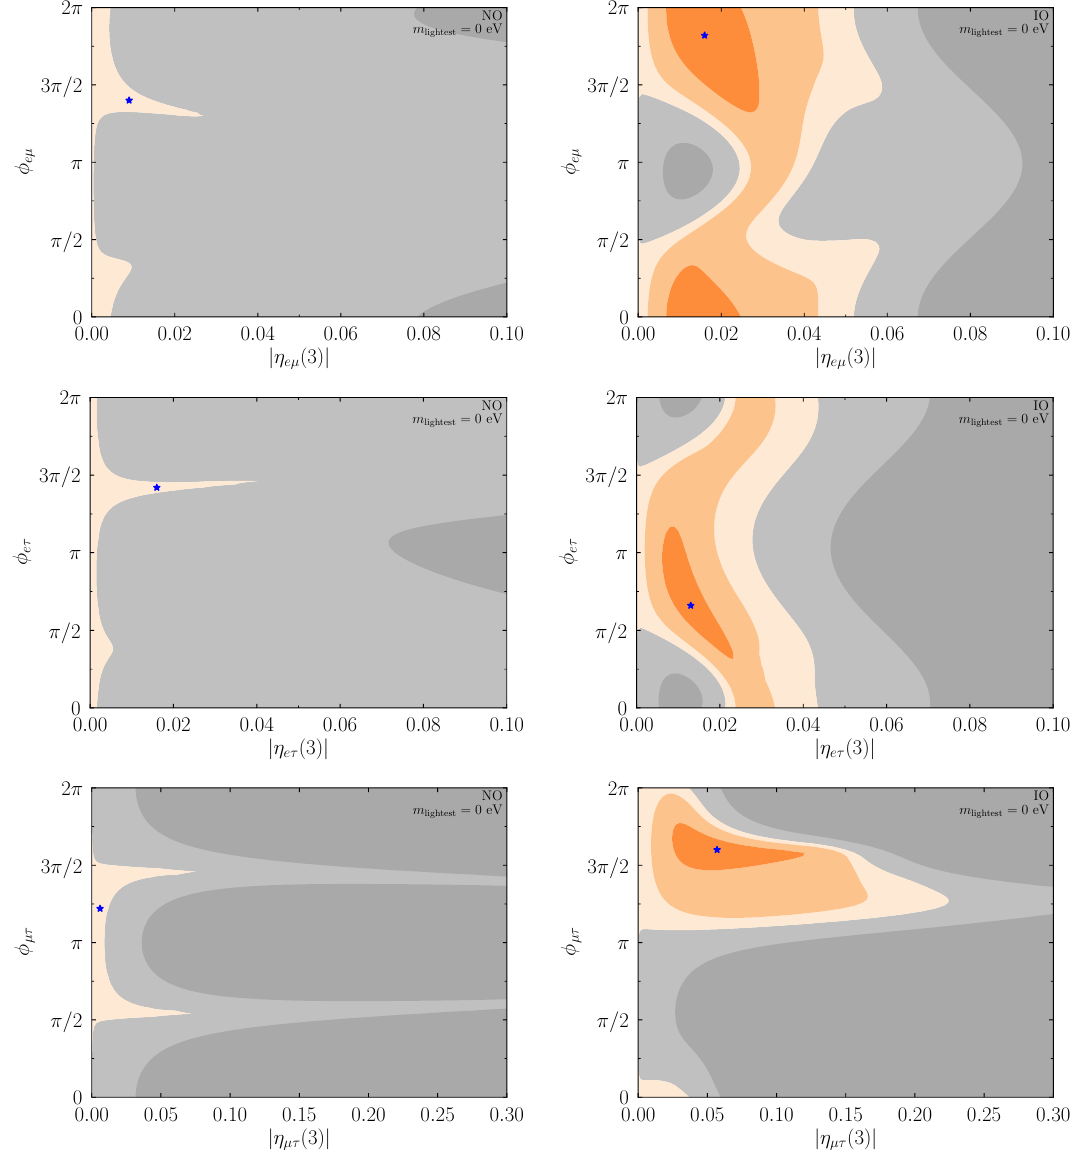
Figure 7 . The preferred and disfavored regions of scalar NSI given by NOvA and T2K data with information from Daya Bay and KamLAND data as well. ∆ m 2 , θ , and δ are minimized over 23 31 and θ , θ , and ∆ m 2 are fixed to the best fit values from Daya Bay and KamLAND. The top, 13 12 21 middle, and bottom rows correspond to η (3) , η (3) , and η (3) respectively, and the left and eµ eτ µτ right columns correspond to the NO and IO respectively. The mass of the lightest neutrino is taken to be zero here. The (3) refers to the fact that the scalar NSI parameters are plotted as rescaled to a density of 3 g/cm 3 . The blue stars are the best fit points, the light gray regions are slightly disfavored and the dark gray regions are disfavored at 68% CL. The successive orange colors represent integer units of ∆ χ 2